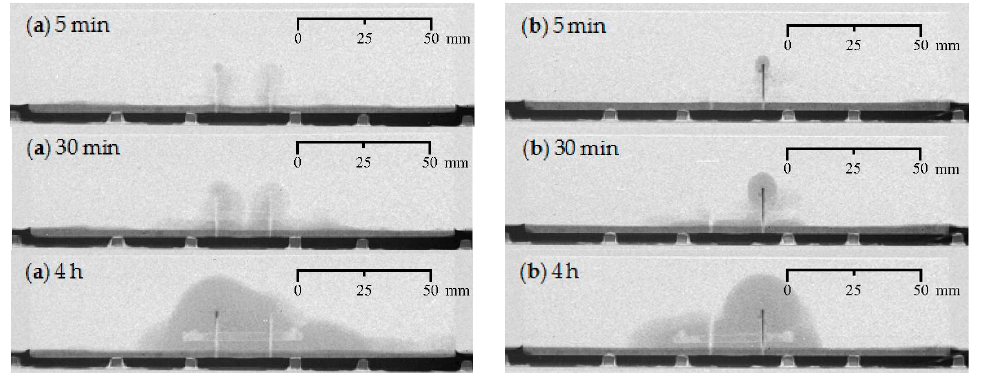
Figure 8. Visualization of the water uptake as a function of exposure time using neutron radiography for mortar prisms with two cracks healed: ( a ) crack healing with PU_HV (representative sample: CR_2_PU_HV_C); and ( b ) crack healing with PU_LV (representative sample: CR_2_PU_LV_B).